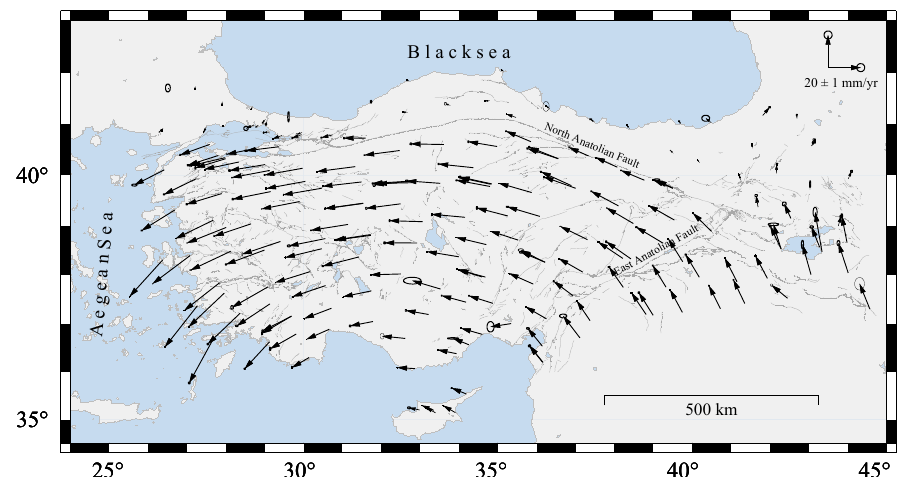
Figure 1. GPS velocity field with respect to Eurasian tectonic plate from [15], gray thin lines show active faults [23].